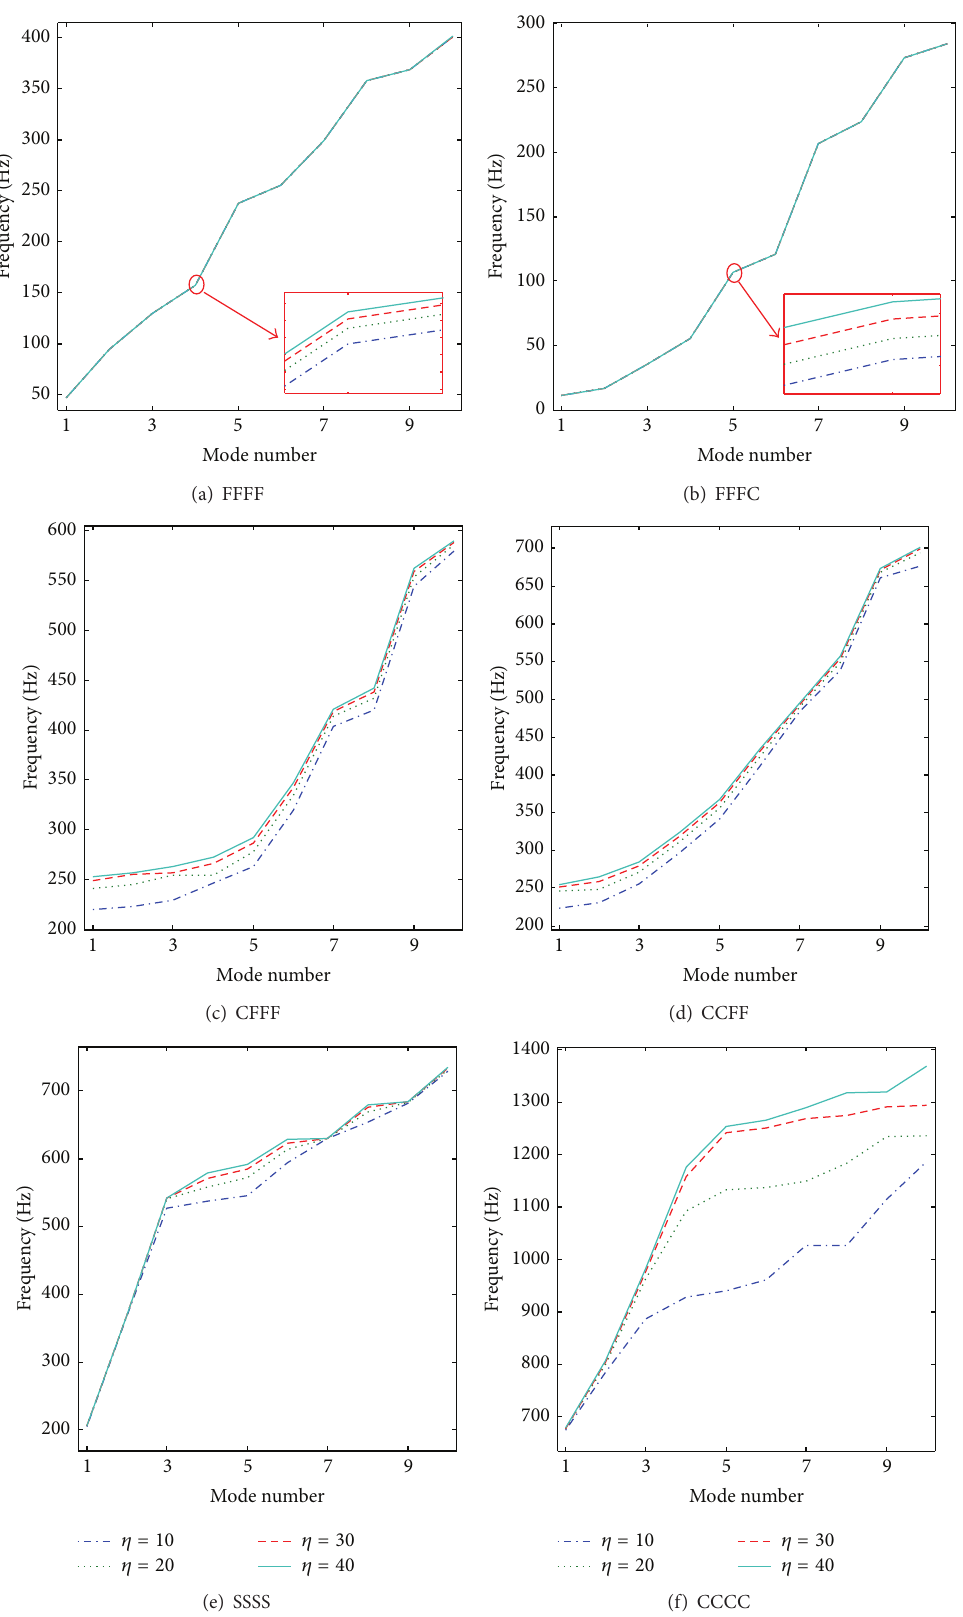
Figure 10: Variation of the first ten frequencies (Hz) against material parameter 𝜂 ( 𝜂 = 𝐸 11 /𝐸 22 ) for an open spherical shell with different boundary